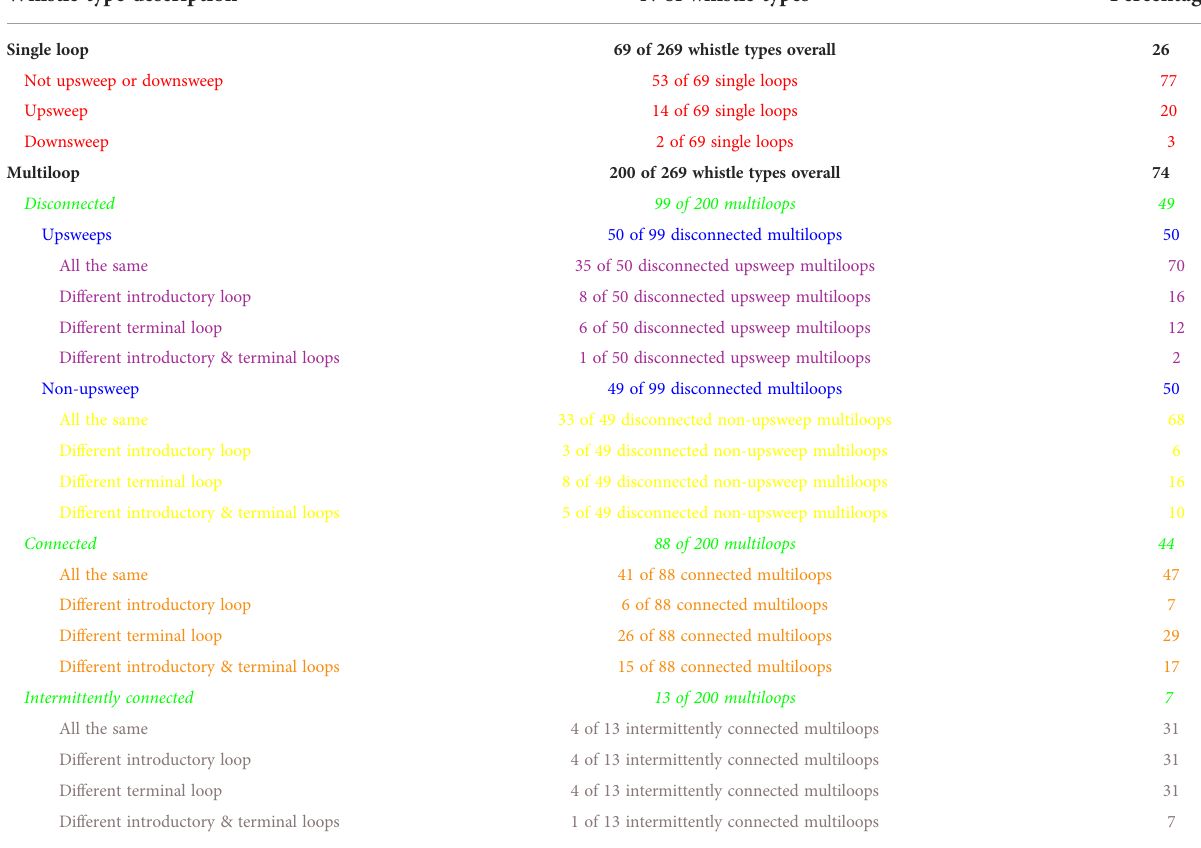
TABLE 1 Breakdown of whistle contour